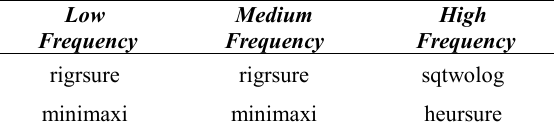
Table 1. Threshold criterion